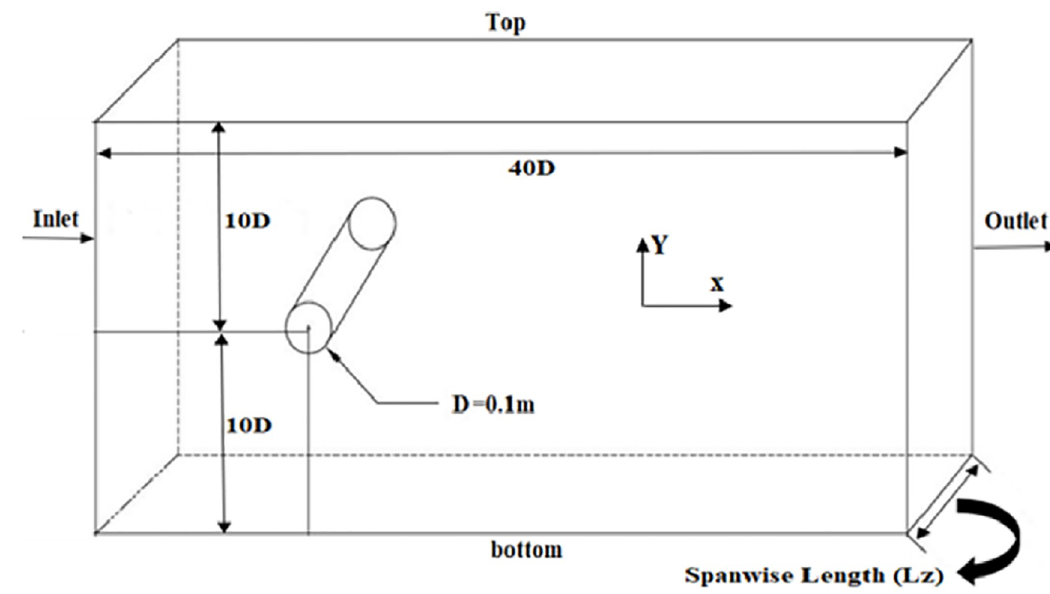
Fig 1. CAD model and boundary